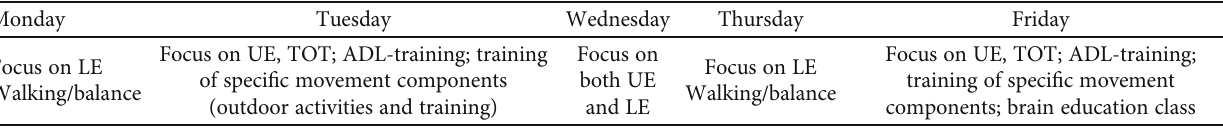
Table 1: Description of the daily overall focus in the Activity